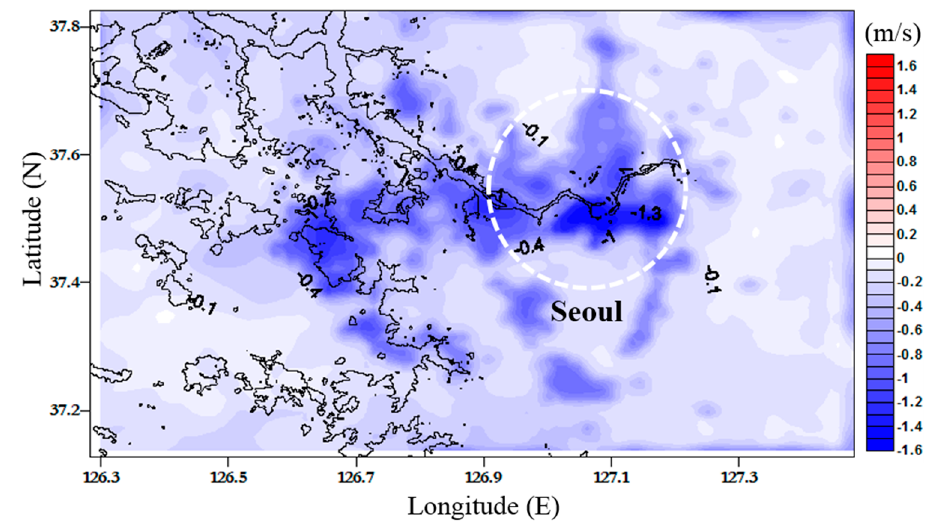
Figure 10. Wind speed difference between WRF and WRF–UCM simulation at 12:00 p.m. (negative value means that WRF over-predicted wind speed than WRF–UCM).